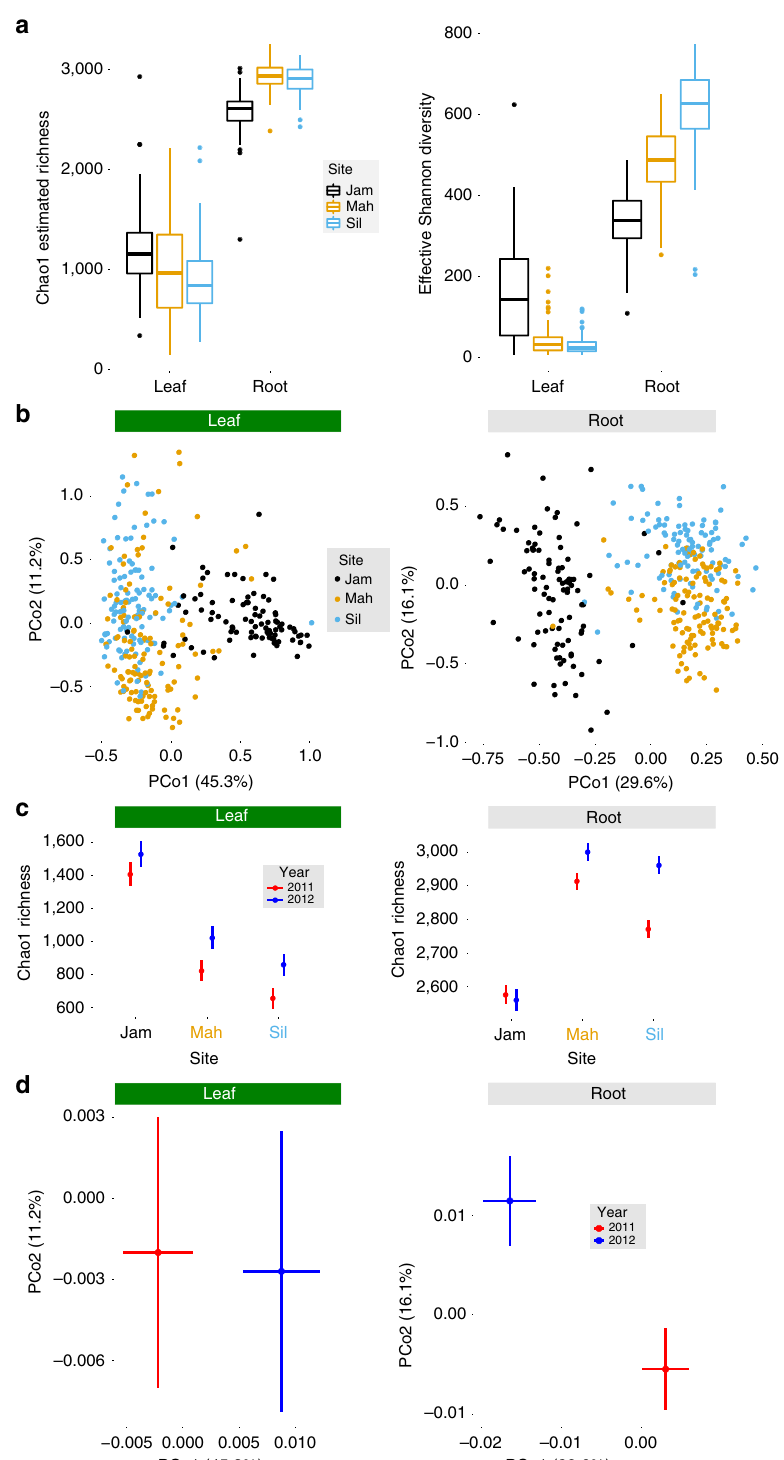
Figure 2 | Habitats differ strongly in richness and composition of leaf- and root-associated bacterial communities. Sample sizes are N ¼ 306 for leaves and N ¼ 310 for roots. ( a ) Mean Chao1 richness and effective Shannon diversity ( e Shannonentropy ) differed among field sites for both roots and leaves (ANOVA, P o 1.5e (cid:2) 11; detailed statistics are found in Table 1). The bottom and top edges of the boxes mark the 25th and 75th percentiles (that is, first and third quartiles). The horizontal line within the box denotes the median. Whiskers mark the range of the data excluding outliers that fell more than 1.5 times the interquartile range below the first quartile or above the third quartile (dots). ( b ) PCoA of weighted UniFrac distances reveals that field site is a major source of bacterial community variation in both leaves and roots (ANOVA, P o 9e (cid:2) 7; detailed statistics in Table 2). Similar patterns result from PCoA of unweighted UniFrac distances, which only considers presence/absence of OTUs (Supplementary Fig. 4). ( c ) a -Diversity increased between 2011 and 2012 at most sites (ANOVA, P o 0.05; detailed statistics in Table 1). Least-squares mean Chao1 richness is plotted for each year and each site; error bars represent 1 s.e.m. ( d ) Microbiome composition changed moderately between 2011 and 2012 (ANOVA, P ¼ 0.055 in leaves, P o 0.01 in roots; detailed statistics in Table 2). Least- squares mean PCo1 and PCo2 are plotted with s.e.m. to show effects of year while controlling for other sources of variation using